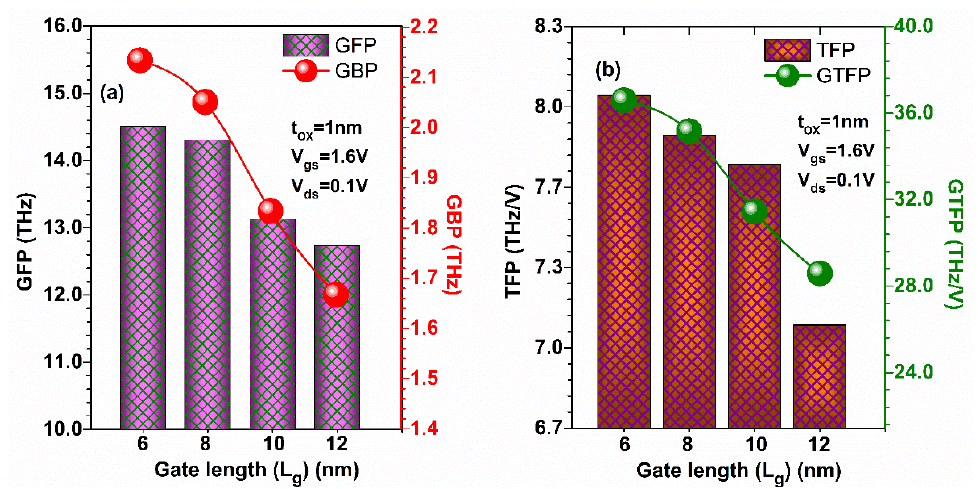
Figure 14. ( a ) GFP and GBP at various gate lengths of GaN-SOI-FinFET. ( b ) TFP and GTFP at var- ious gate lengths of GaN-SOI-FinFET.